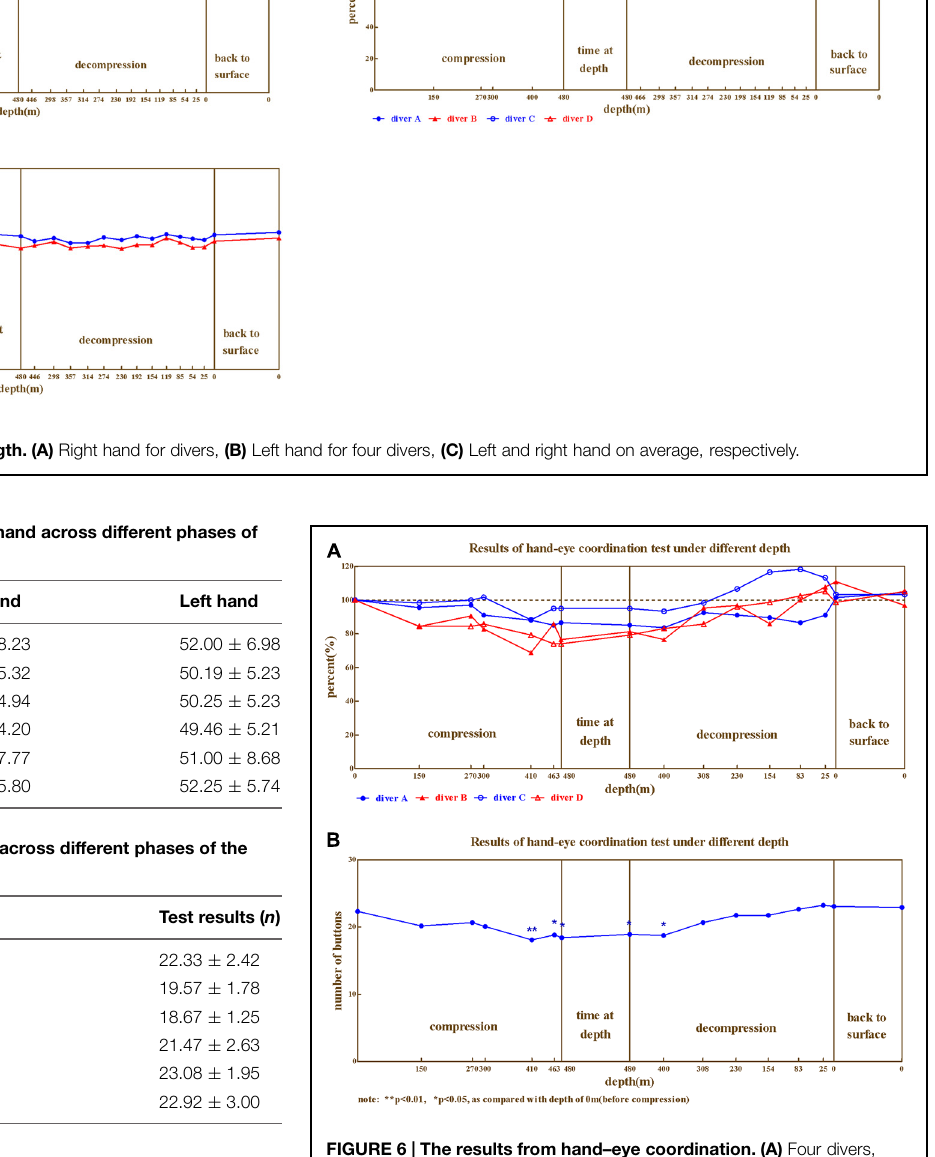
phase ( P < 0.05 to predive), and returned to baseline level during the decompression phase ( P > 0.05 when compared to